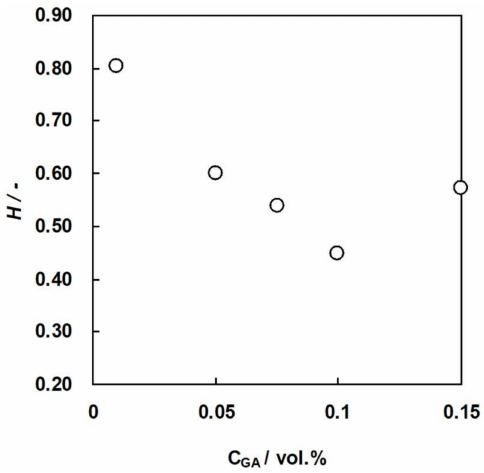
Figure 9. Water content, H , of C-HF membranes as a function of GA concentration.